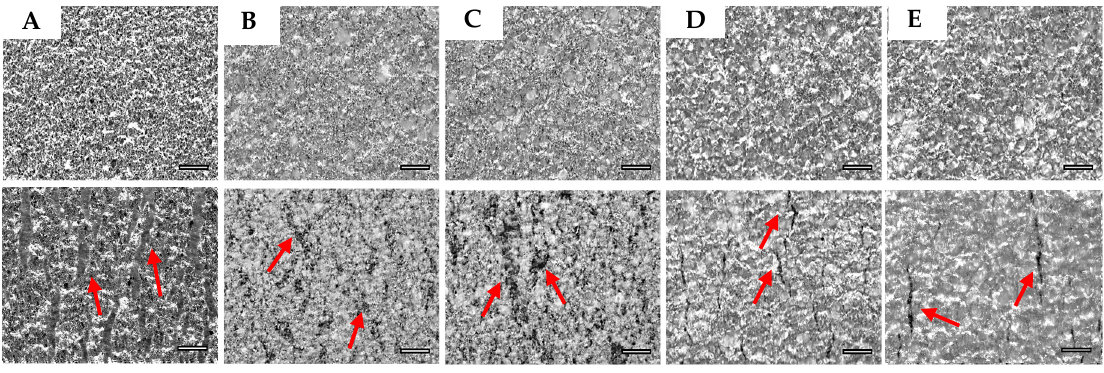
Figure 9. Optical microscope images of the transition area from all sets of samples (sets 1–5 are marked by A – E ) when they are not stretched (upper images) and when they are stretched up to 60% (lower images). The scale bar in all images is 100 μ m.